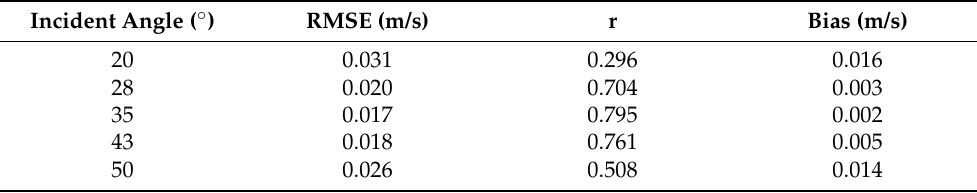
Table 11. Statistics of the estimation results under different incident